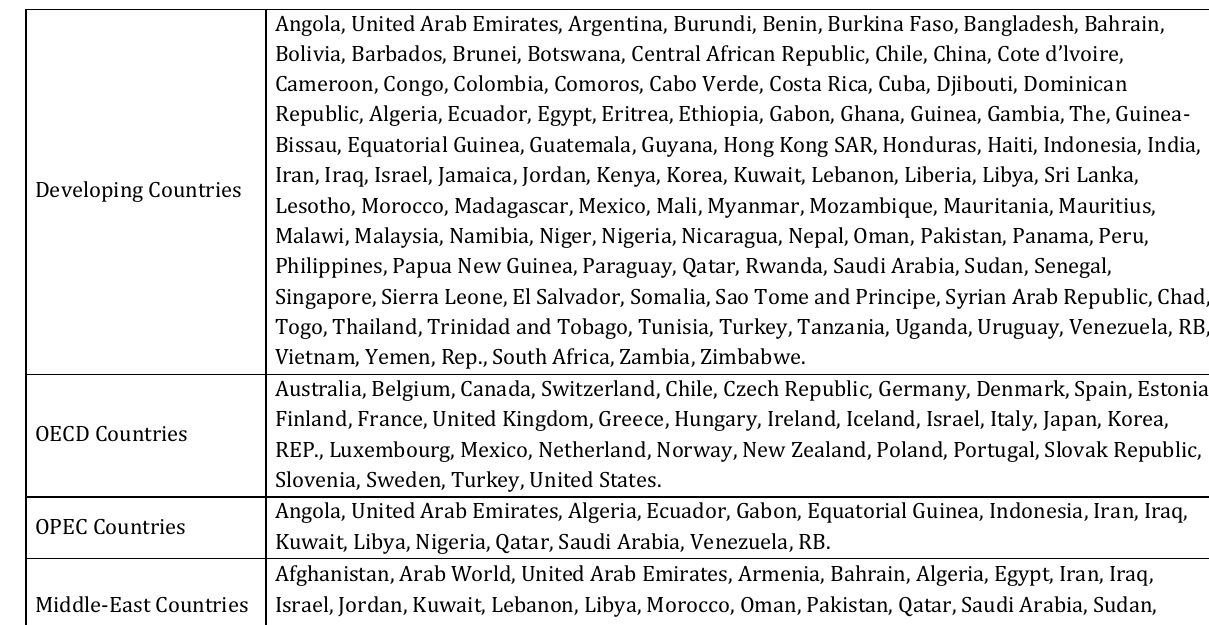
Table 1. List of Countries, World Bank